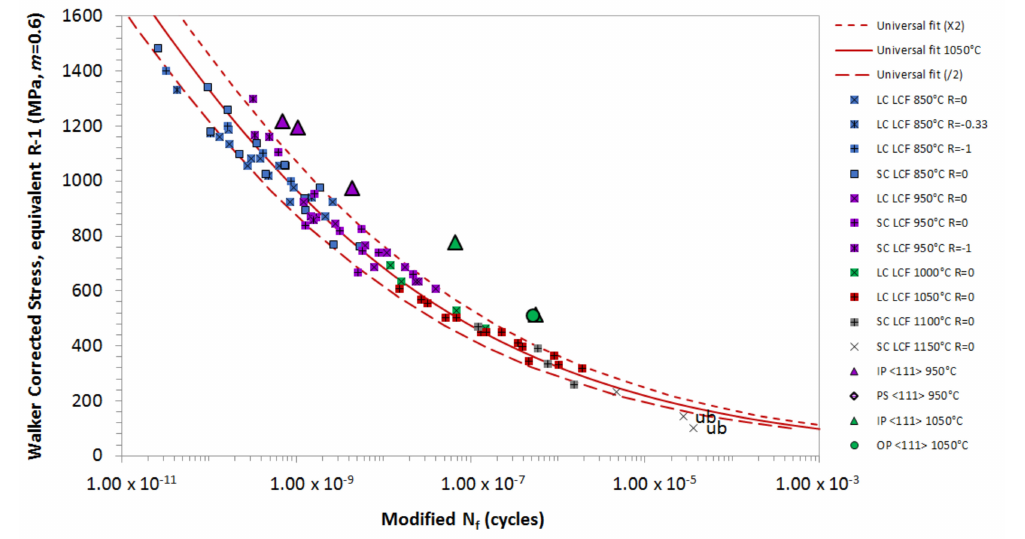
Figure 13. Final TMF model fitted to all the <111> orientated CMSX-4 ®